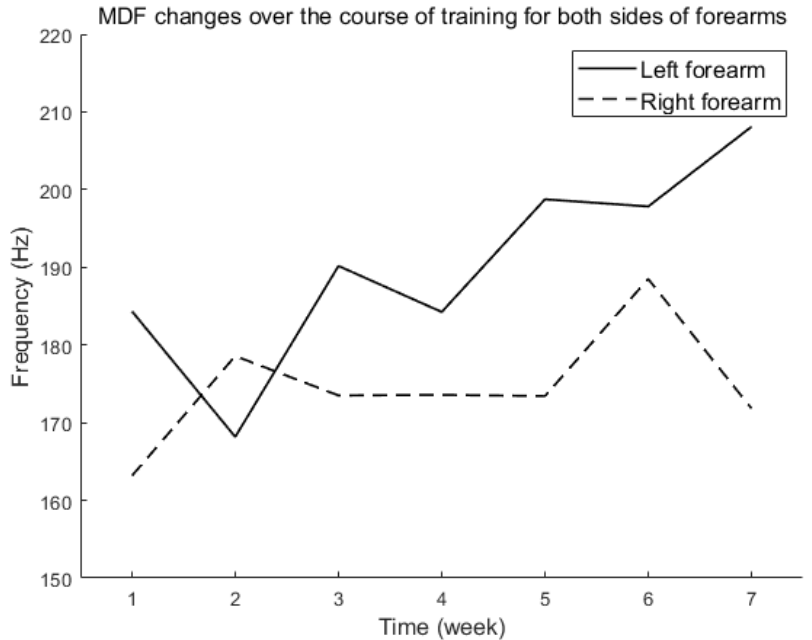
Figure 4. MDF changes across training period for both sides of forearms.